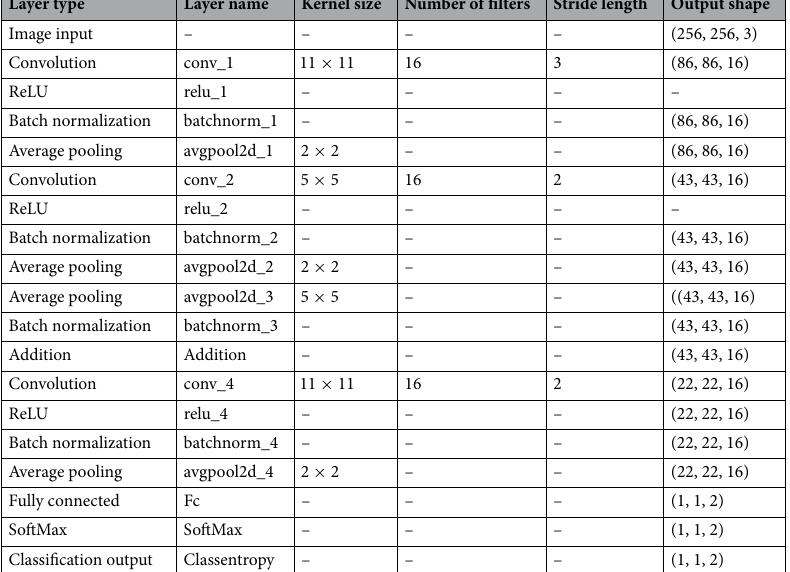
Table 1. The architecture of the proposed deep convolution network.